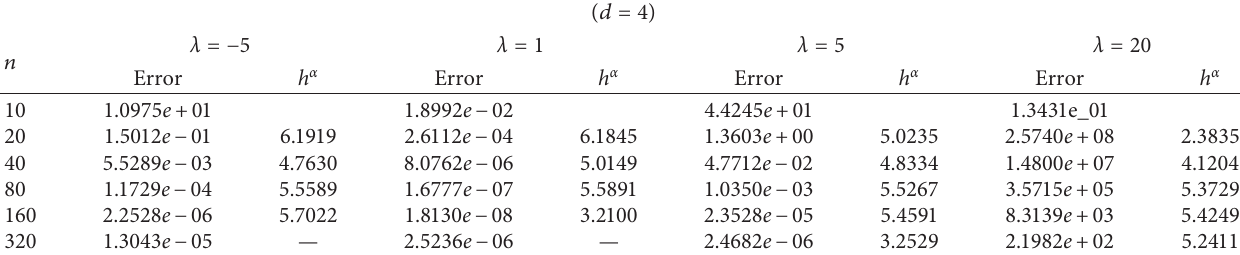
Table 4: Errors and convergence rate of the Chebyshev point with different λ .